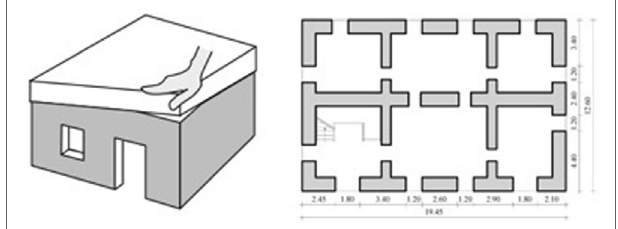
FigURe 6 | From the left: “Box” behavior [adapted from Touliatos (1996)]; typical plan of a masonry building (Parisi and Augenti,